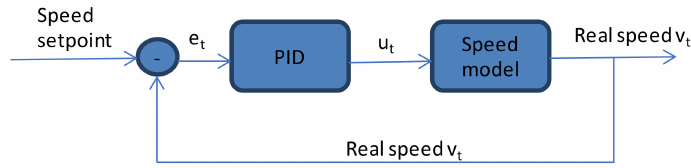
Figure 1. Block diagram of the system to be